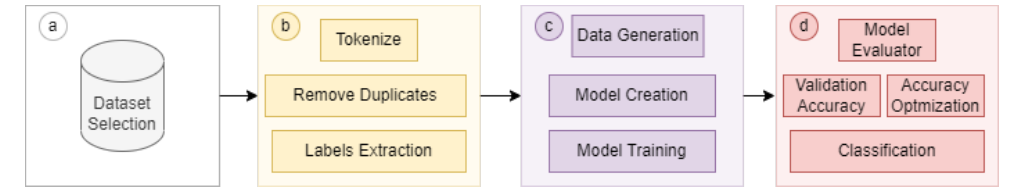
Figure 2. Overview of the proposed approach illustrating the: ( a ), Dataset ( b ), Preprocessing ( c ), Deep learning model ( d ),